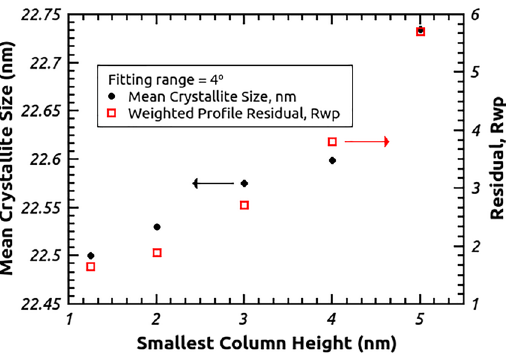
Figure 7. Mean crystallite size and residual error as a function of minimum chord length Further, the effect of the minimum chord length is much stronger than the fitting angular range on the experimental